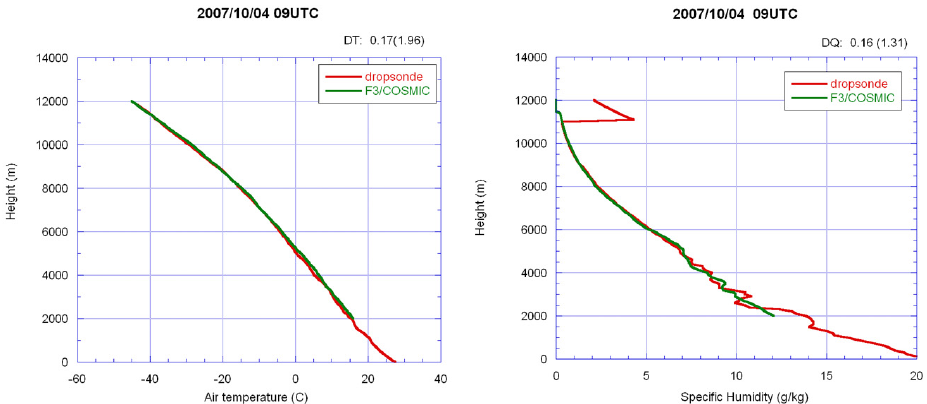
Fig. 21. Comparison of FORMOSAT-3/COSMIC atmospheric retrieval profile (green) with high-resolution in-situ dropsonde data (red). Left panel: temperature ( ◦ C). Right panel: specific humidity (gkg − 1 ) (source: Po-Hsiung Lin, National Taiwan University, 2010).